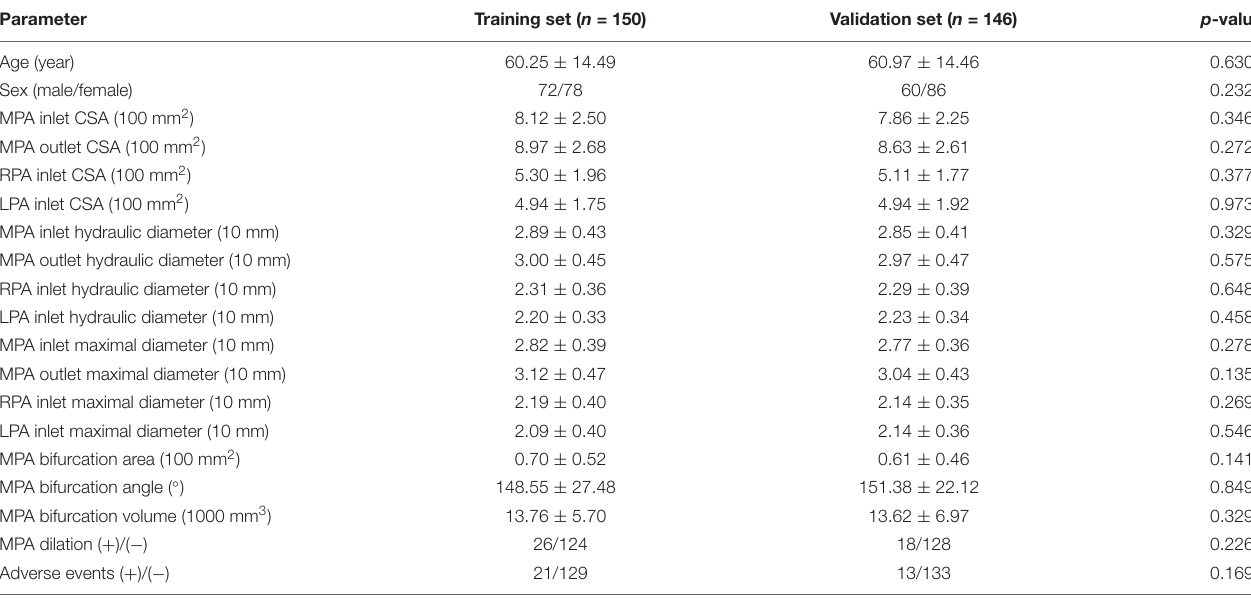
TABLE 2 | Comparison of parameters between the training set and the validation set after random grouping.